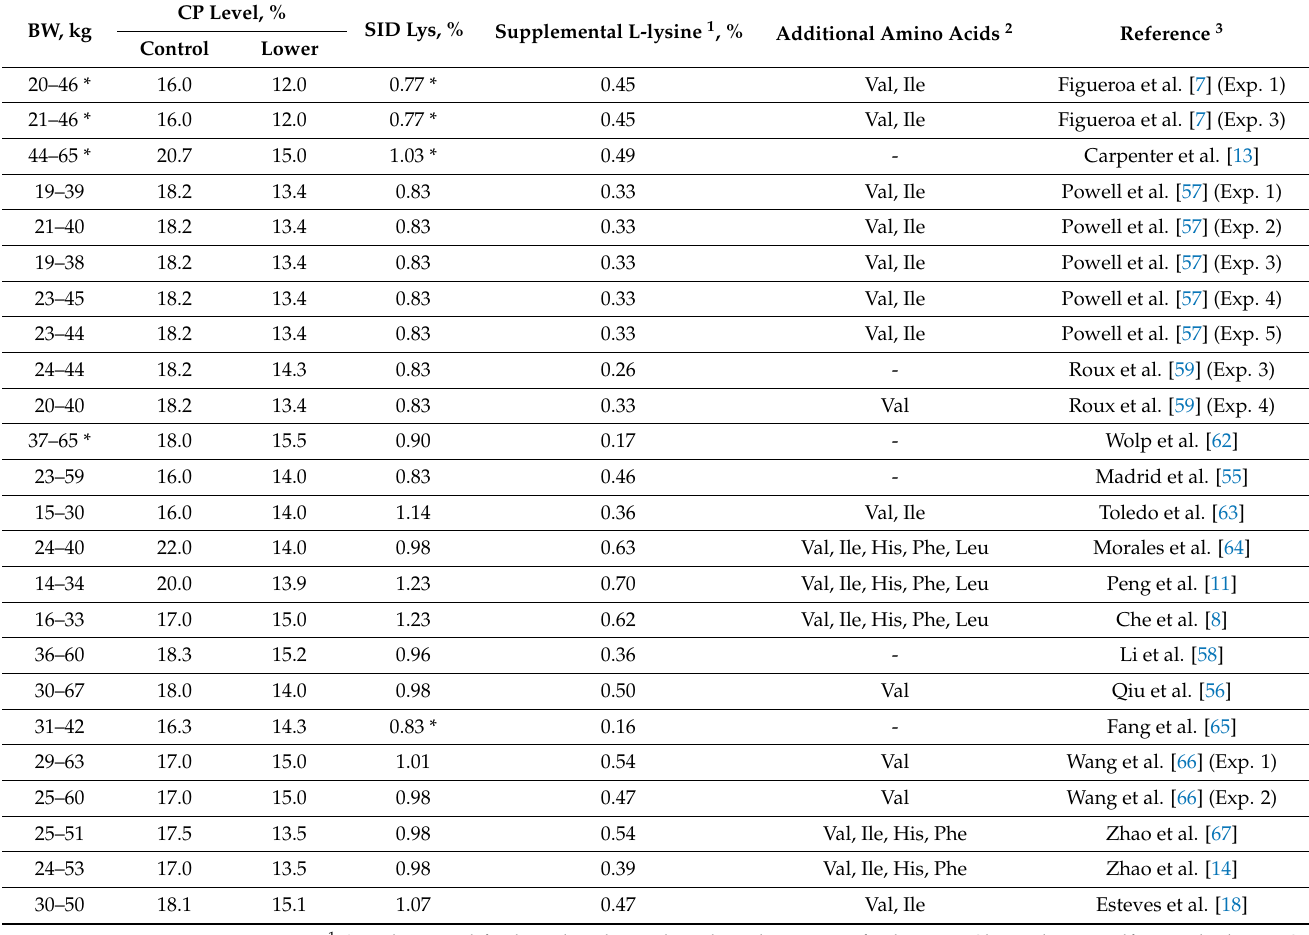
Table 2. Summary of the studies included in the meta-analysis to estimate changes in average daily gain and gain to feed in the growing